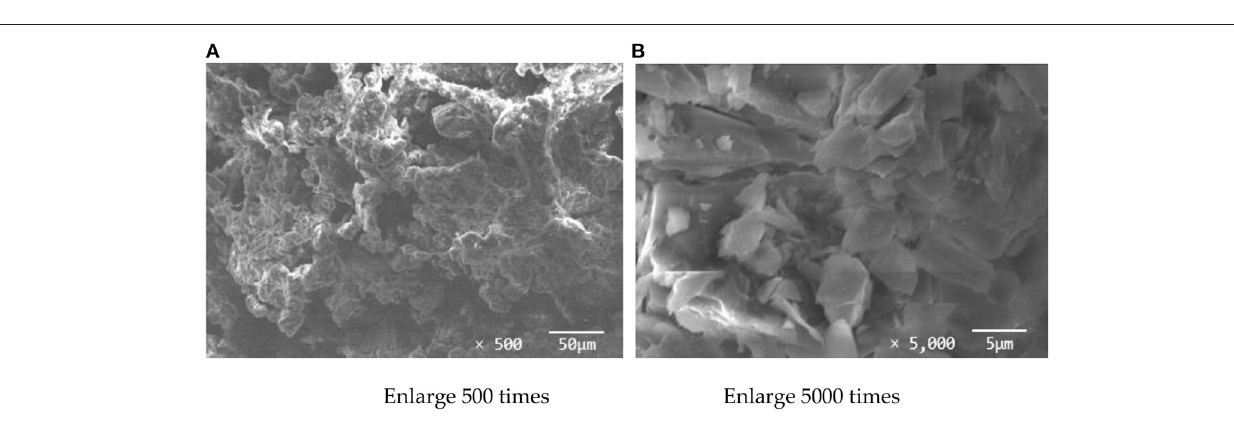
temperature performance compared to a polyester-based TPU- modified asphalt (see Figure 21